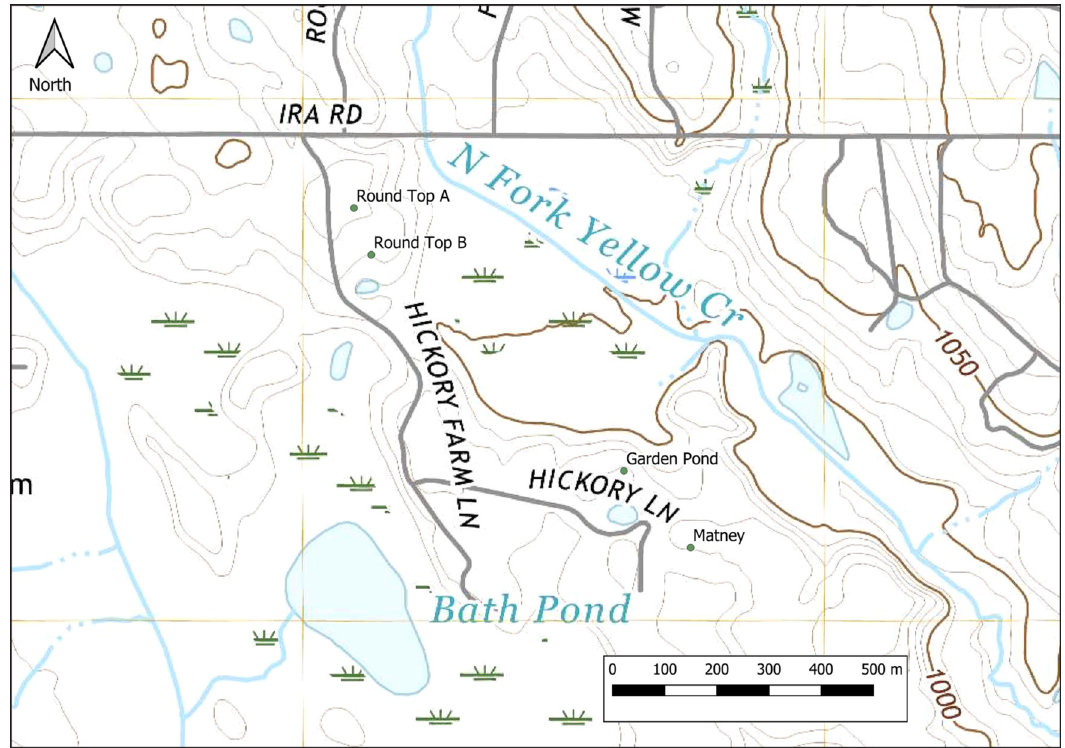
Figure 6: Locations of sites surveyed within Bath Nature Preserve.